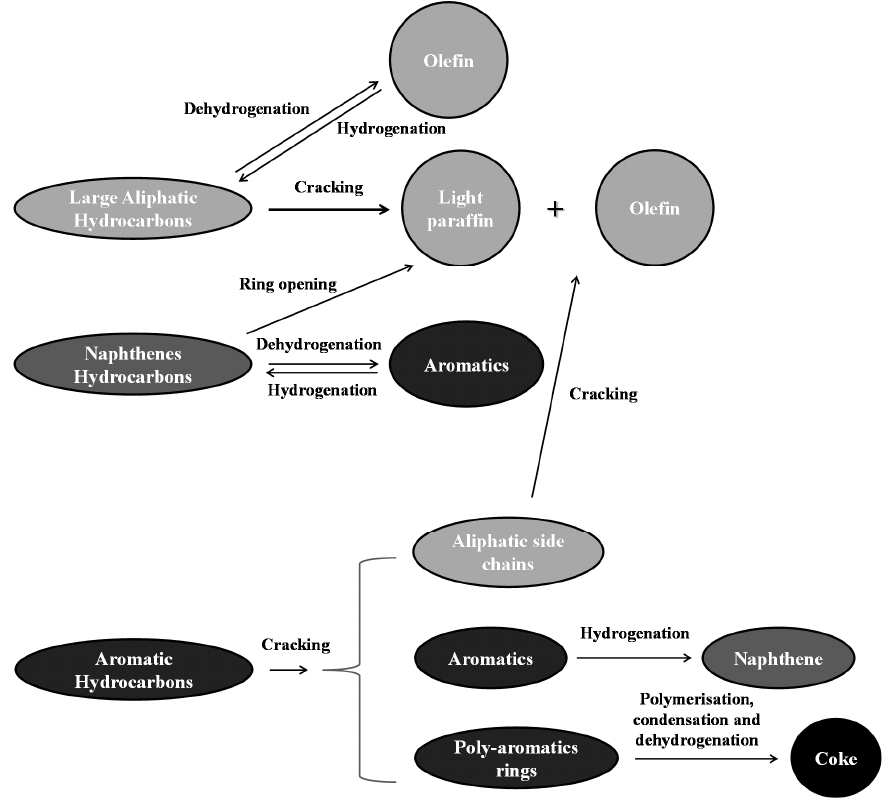
Figure 9. Classes of catalytic upgrading reaction pathways for large aliphatic, naphthenic, and aromatic species in the heavy crude in the absence and presence of hydrogen.